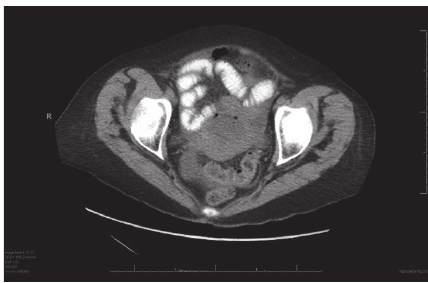
Figure 1: CT abdomen/pelvis showing pneumoperitoneum as well as air within the wall of the